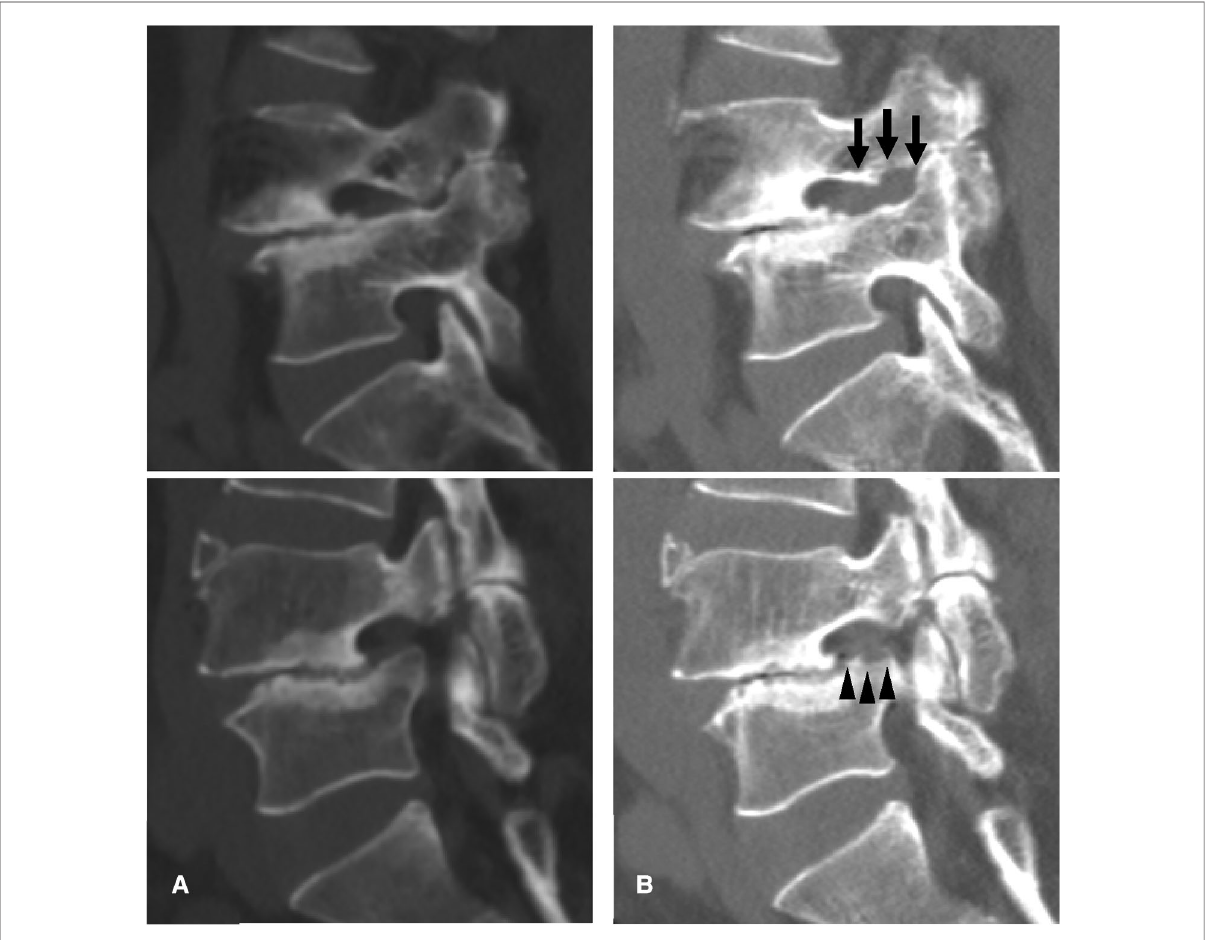
FIGURE 3 An illustrative case of a 62-year-old Male patient. (A) Preoperative computed tomography (CT) images showing foraminal stenosis with spondylolisthesis at the L4-5 level. (B) Postoperative CT images showing foraminal decompression with resection of a part of the upper pedicle (arrow) and lower vertebral endplate